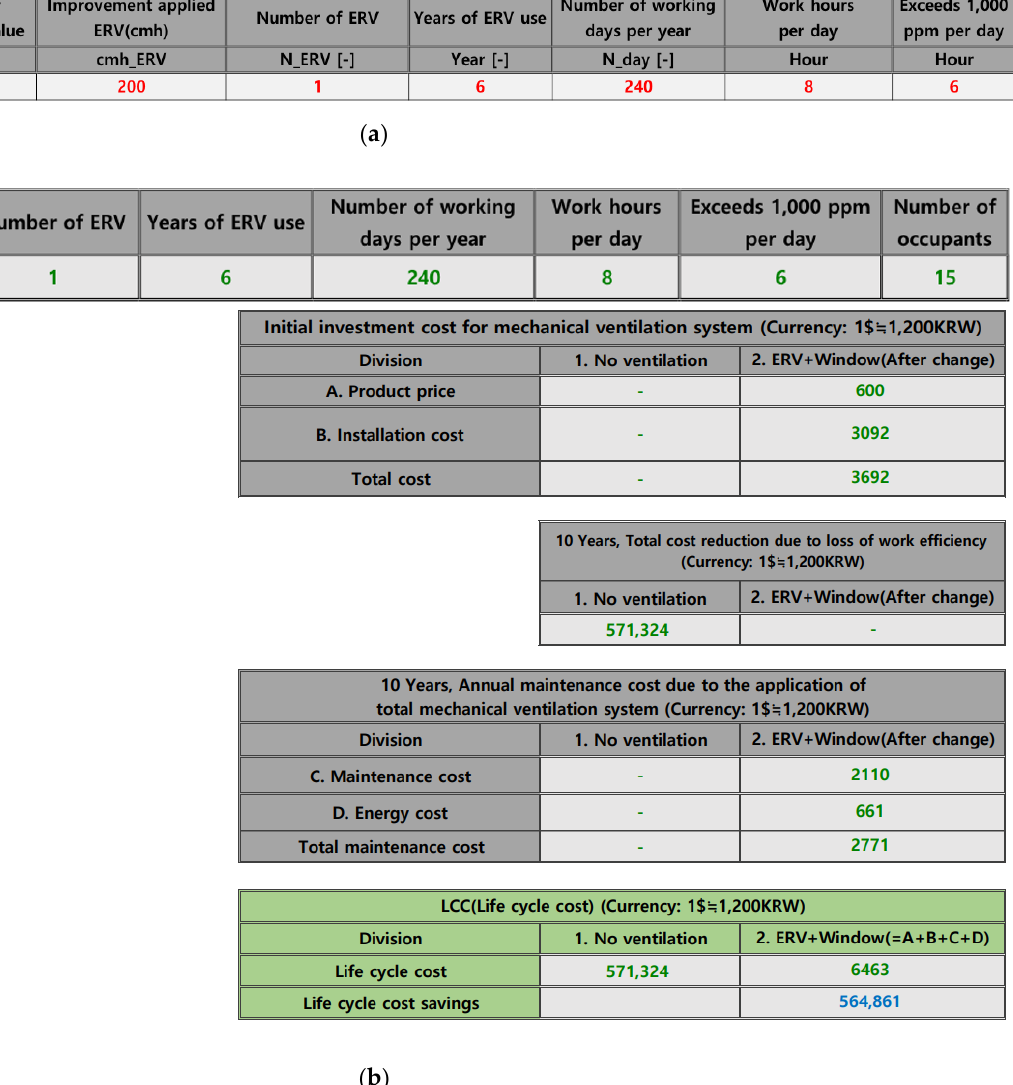
Figure 18. ( a ) Example of inputs for Office Space B improvement, and ( b ) Office Space B LCC anal- ysis result.